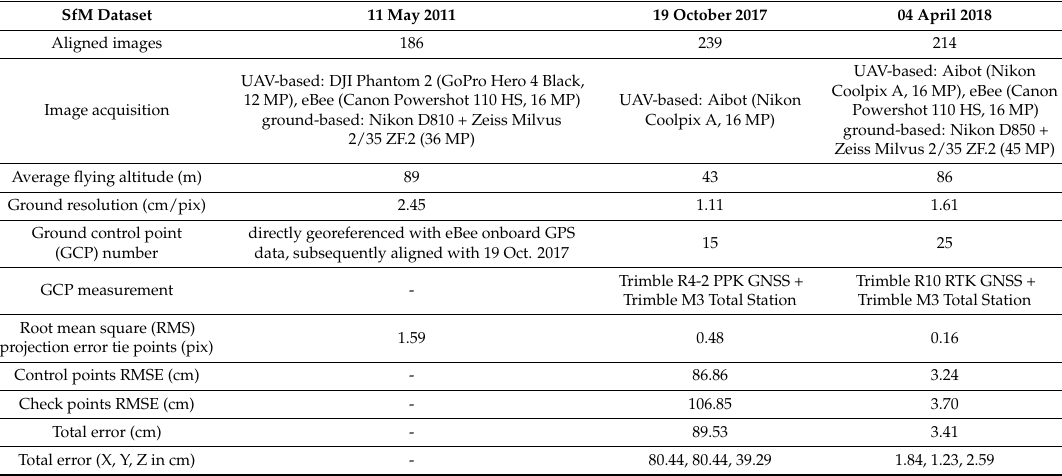
Table 5. SfM parameters for the point clouds of the Naundorf